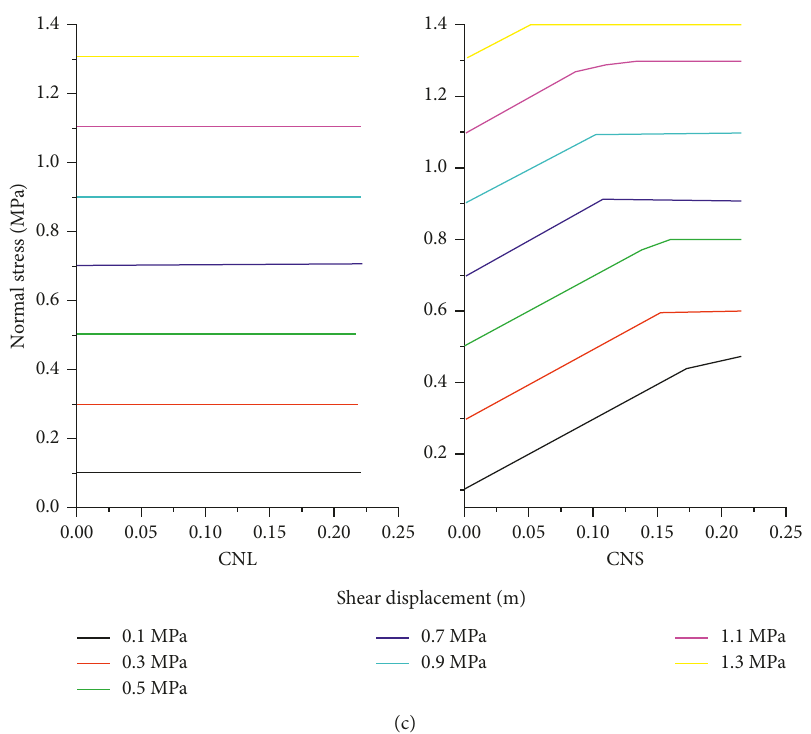
Figure 4: Shearing characteristics curve of the clean joint under CNL and CNS conditions. (a) Shear stress-shear displacement curve. (b) Normal displacement-shear displacement curve. (c) Normal stress-shear displacement curve.